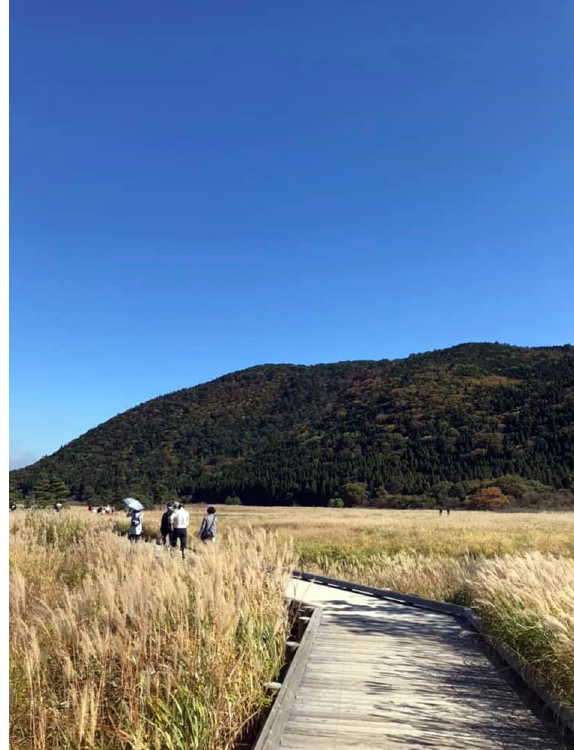
Fig. 1. Typical autumn scenery in Kuju with pampas grass and wooden boardwalk through the marsh. Source: photos taken by authors.